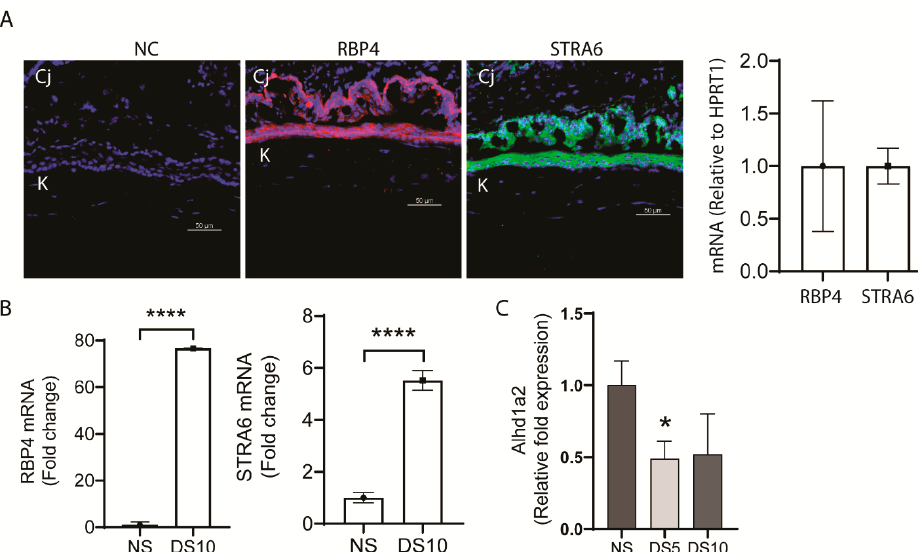
Figure 1. Expression of stimulated by retinoic acid 6 (STRA6) and retinol binding protein 4 (RBP4) in the ocular surface epithelium. ( A ) Representative immunofluorescence images of ocular surface epithelium in sections taken from young C57BL/6 (B6) mice showing expression of STRA6 (green) and RBP-4 (red) both in the cornea (K) and conjunctiva (Cj). The nuclei were stained with 4’,6’-diamino-2-phenylindole (DAPI) (blue) (left). Relative expression of STRA6 and RBP-4 mRNA in scaped cornea epithelium from young B6 by real time PCR (RT-PCR) (right). ( B ) RBP4 and STRA6 mRNA expression measured by RT-PCR in conjunctiva of 6-week-old B6 mice in normal non-stressed environmental conditions (NS) and after 10 days of desiccating stress induced dry eye (DS10). ( C ) Desiccating stressed induced decrease in aldh1a2 gene expression measured by RT-PCR in the conjunctiva of B6 mice. NS = control non stressed, DS5 = exposure to desiccating stress for 5 days, DS10 = exposure to desiccating stress for 10 days. * p = 0.05, **** p = 0.00001